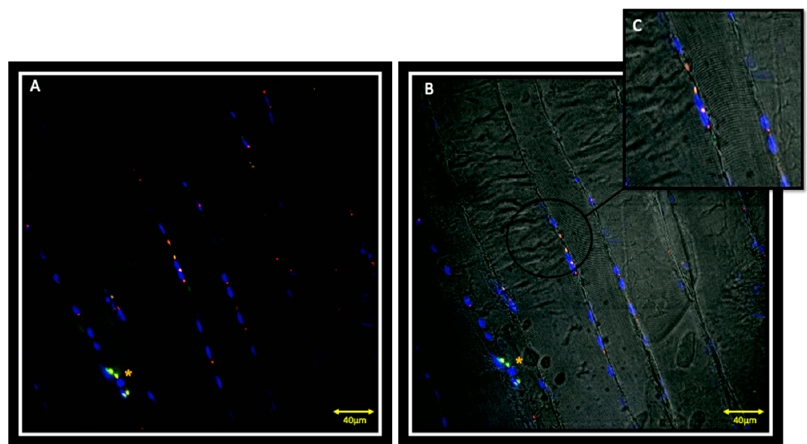
Figure 1. Images of immunofluorescence reactions performed on contralateral masseter muscle; it is possible to observe satellite cells that co-express both PAX7 (red channel) and Myf5 (green channel) ( A , B ). ( C ) sub-figure is an high magnification of PAX7 and Myf-5 positive cells. The yellow asterisk indicates a small group of possibly proliferating PAX7 and Myf-5 positive cells. The yellow fluorescence is obtained from the merge of red and green channels. Nuclei are stained with DAPI (blue channel).